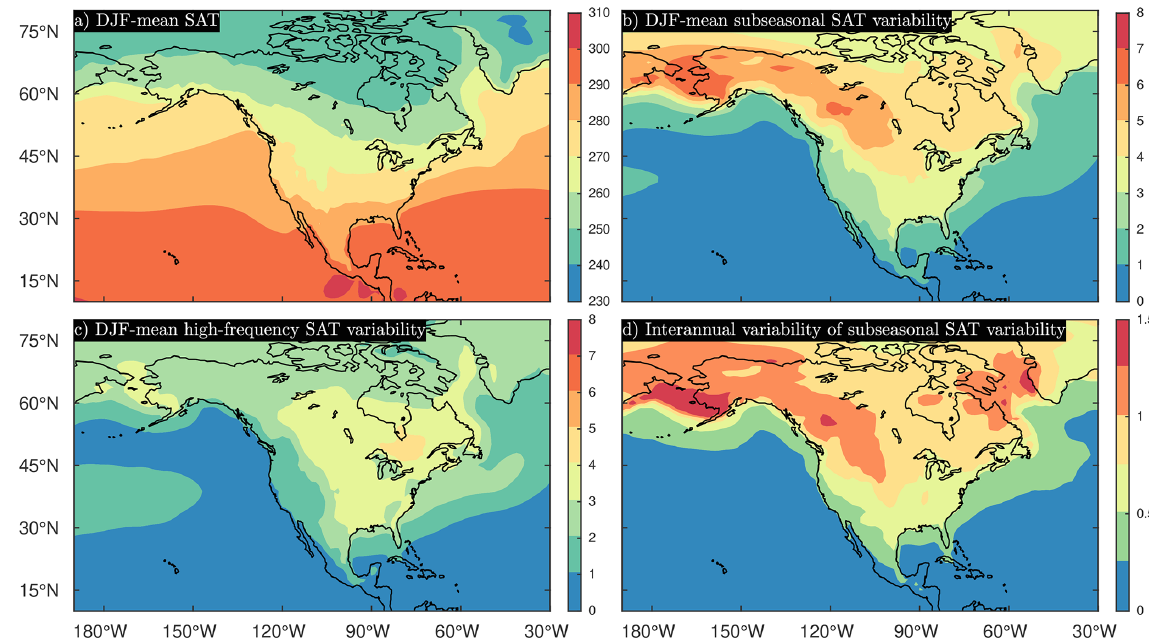
Figure 1. Climatological features of SAT variability (1958–2019). The (a) DJF-mean SAT, (b) DJF-mean subseasonal (10–60d) SAT vari- ability, or SSV, (c) DJF-mean high-frequency (2–8d) SAT variability, and (d) interannual modulations of subseasonal SAT variability are shown with color shadings. All variables are in units of K. Variability is illustrated with the standard deviation.